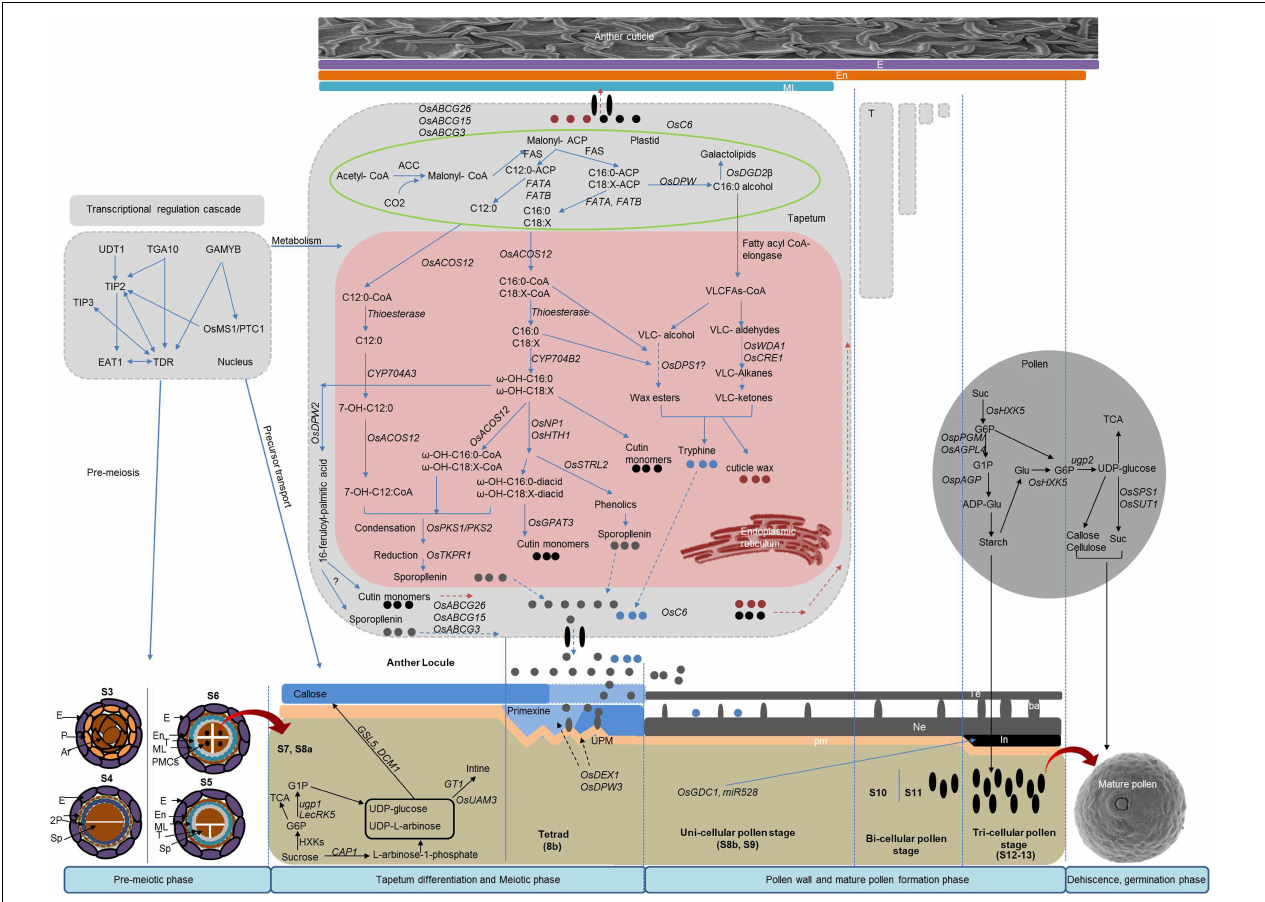
FIGURE 1 | Genetic network of genic male sterility (GMS) genes for anther and pollen development including lipid and polysaccharide metabolism. E, epidermis; En, endothecium; ML, middle layer; T, tapetum; Sp, sporogenous cell; PMC, pollen mother cell; Ne, nexine; pm, plasma membrane; Te, tectum; ba, bacula; In,